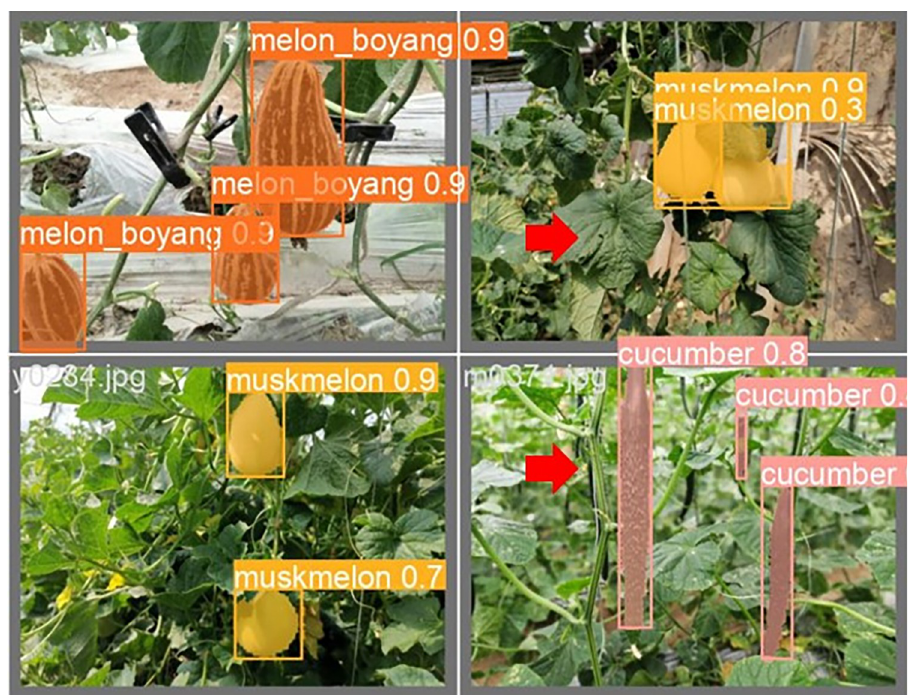
Fig 10. Image results of YOLOv5-Efficientlite.